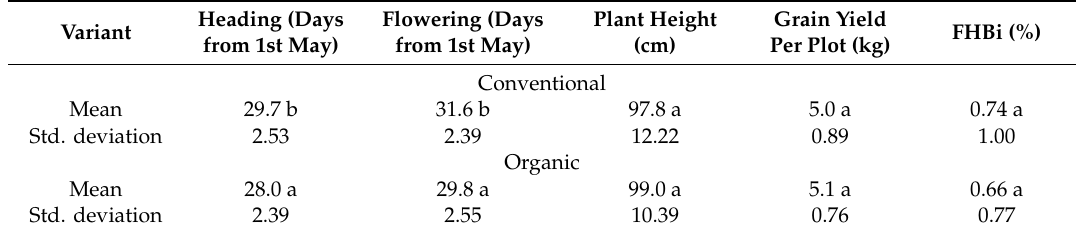
Table 3. Phenotypic characters, grain yield and Fusarium head blight (FHB) infection of 30 wheat cultivars grown in conventional and organic